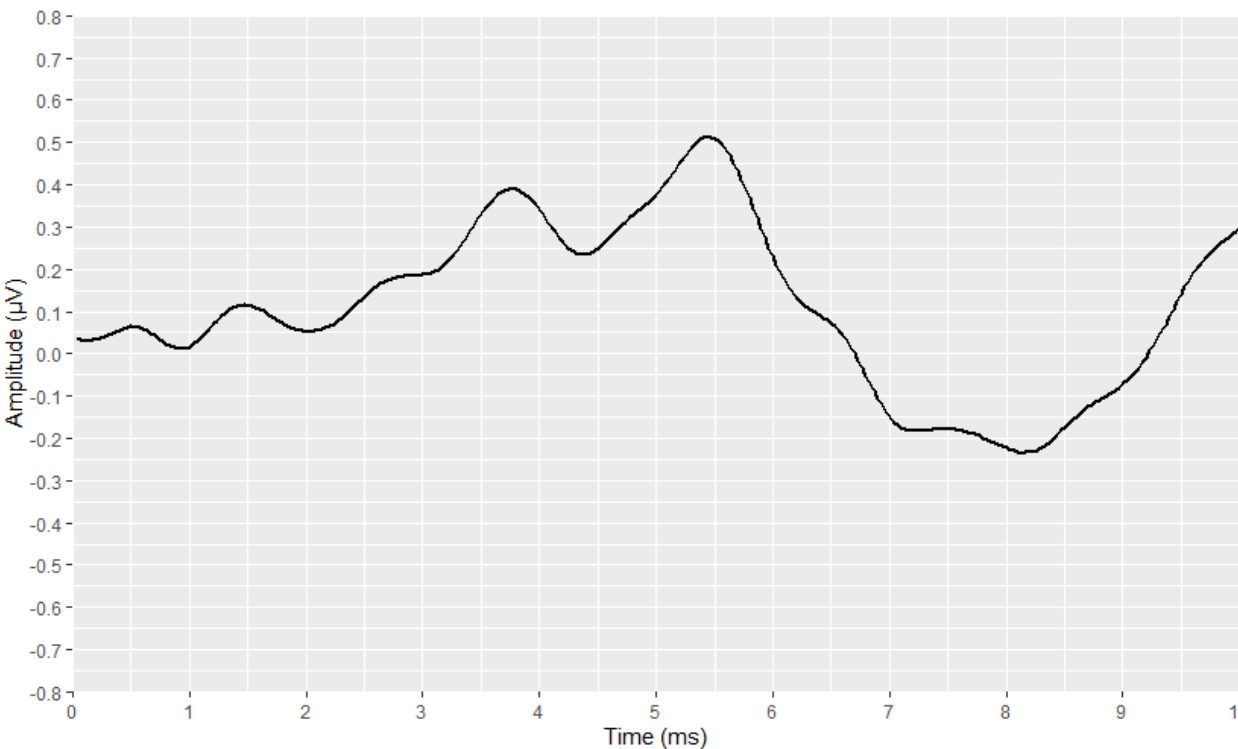
Figure 4. Visualisation of an ABR waveform from raw data (in black).